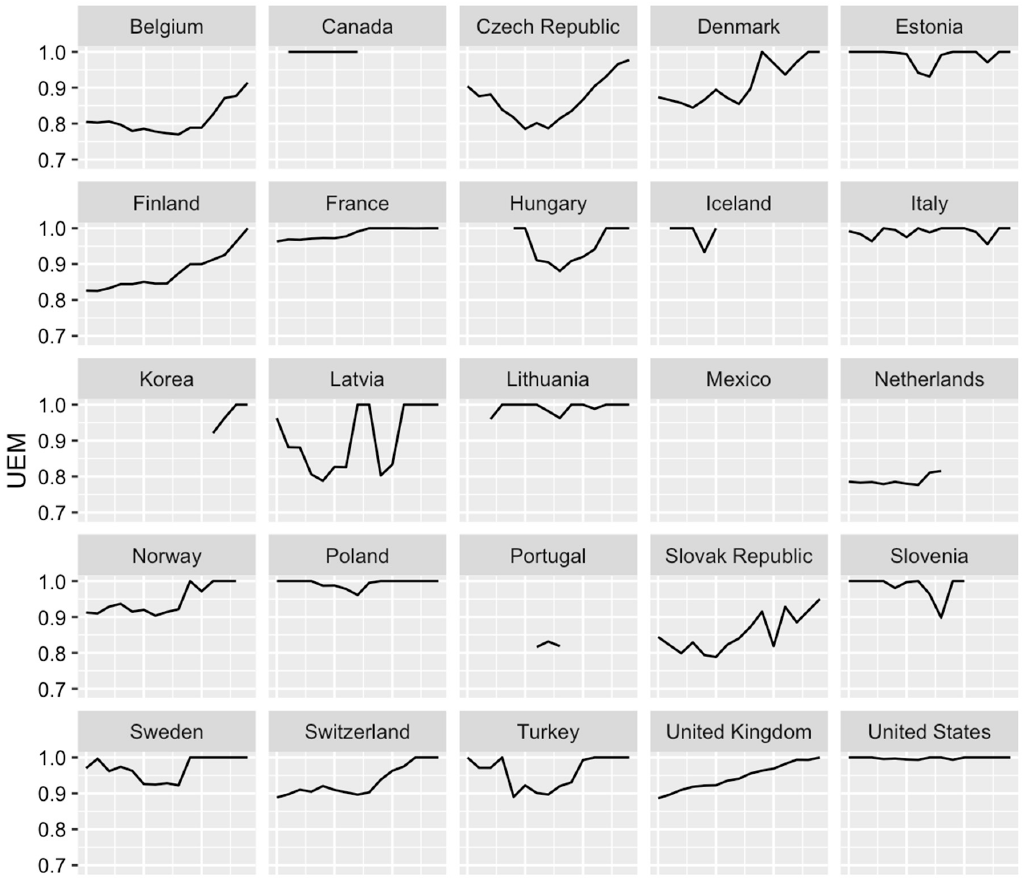
Figure 2. Evolution of UEM for 25 OECD countries.